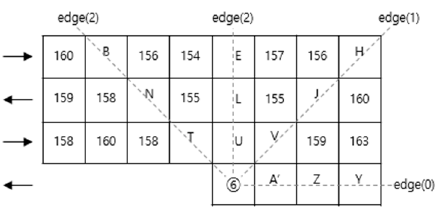
Figure 8. Three edges at ⑥.